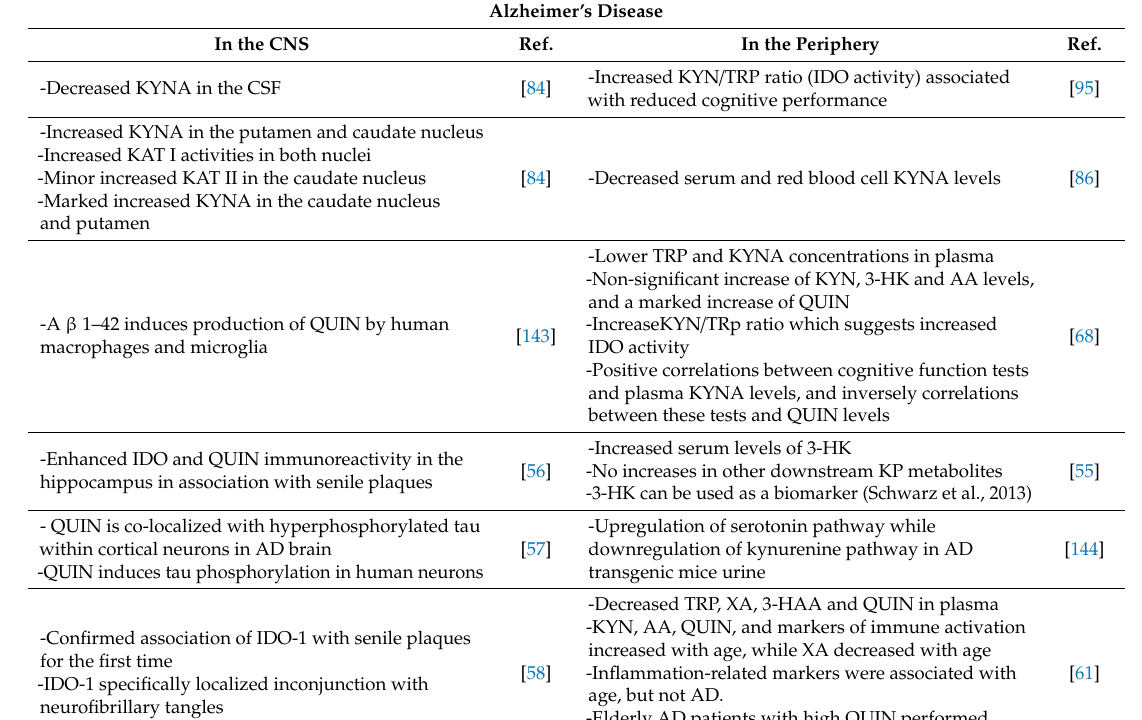
Table A1. Di ff erences of kynurenine pathways in the CNS and the periphery in Alzheimer’s disease. Alzheimer’s Disease In the CNS Ref. In the Periphery